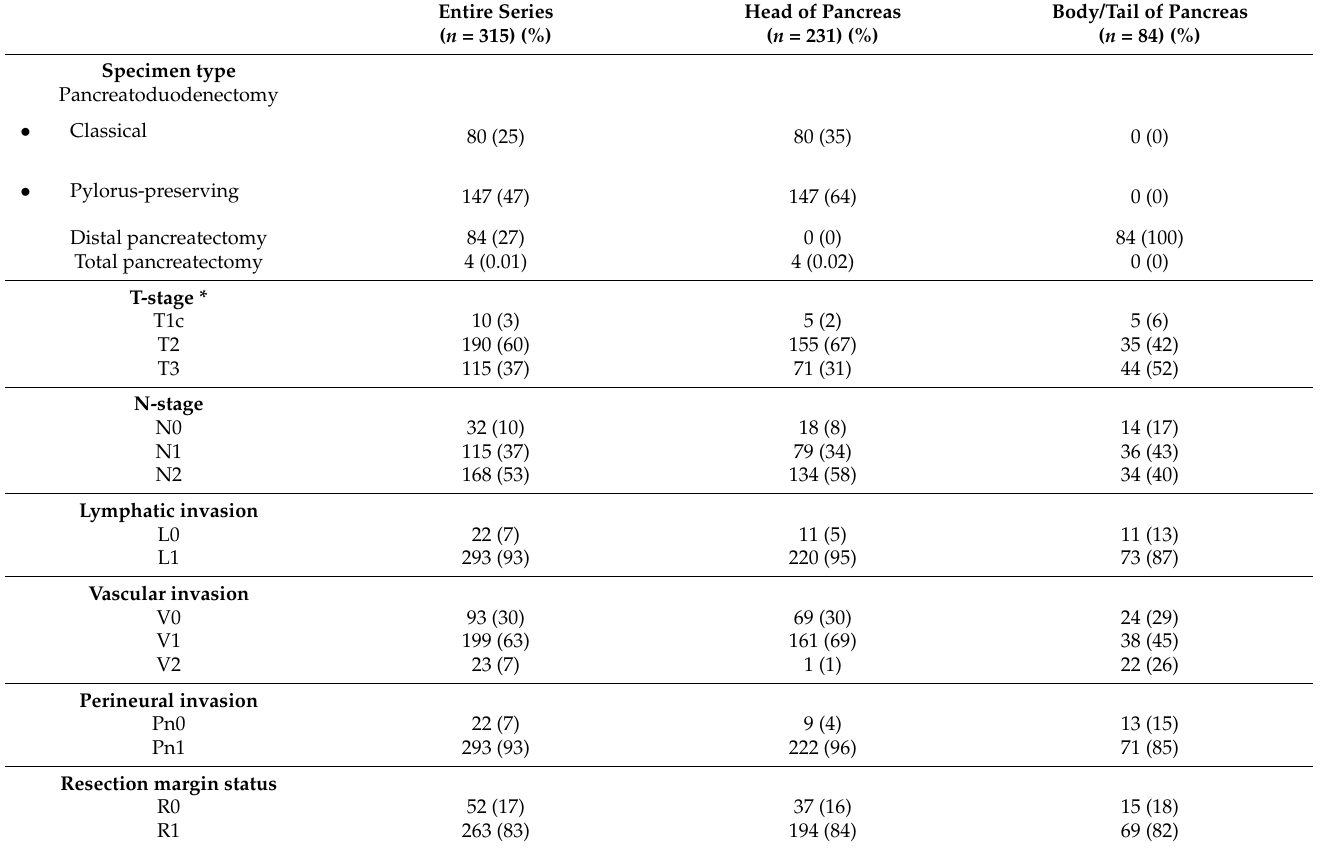
Table 1. Clinicopathological features.